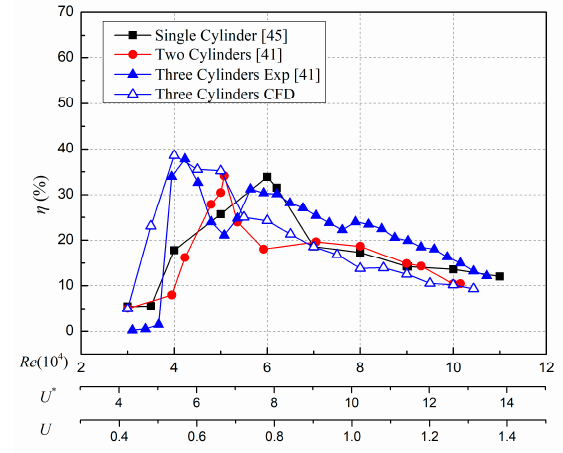
Figure 7. Power conversion efficiency.